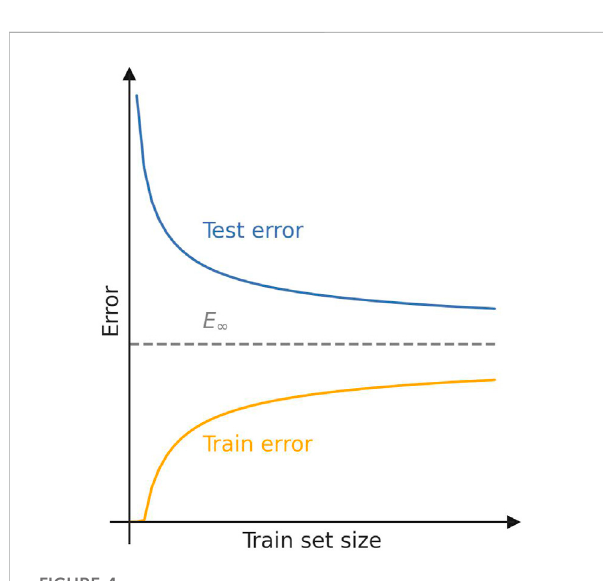
FIGURE 4 Schematic of the general behavior of learning curves for a given ML model.